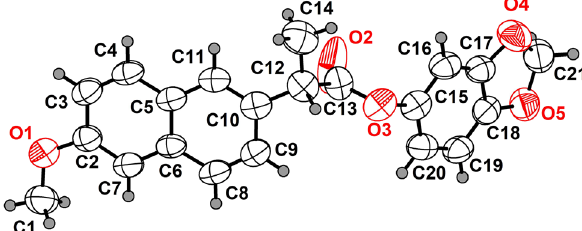
Table  : Data collection and